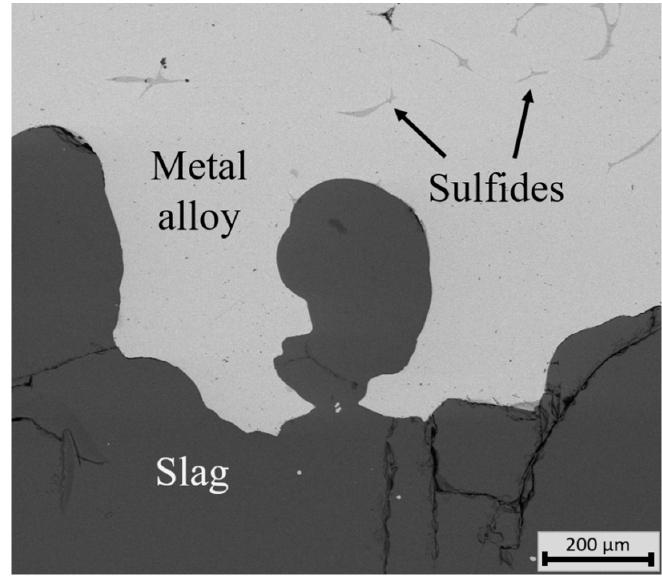
Figure 11. A typical microstructure of a quenched sample. This specific sample was held for 60 min at 1350 °C.